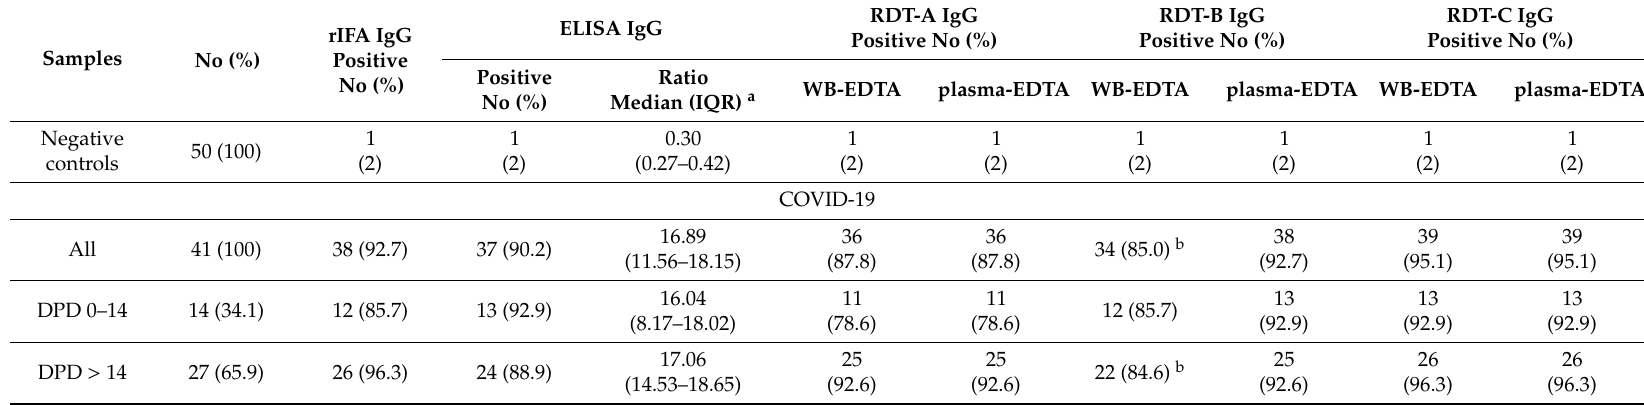
Table 1. SARS-CoV-2 IgG detection characteristics by various immunoassays.